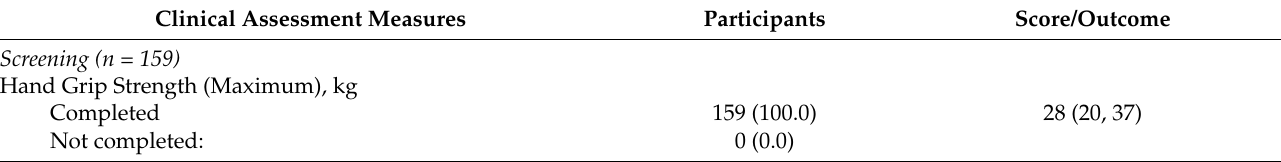
Table 4. Adherence to and scores of the clinical screening and assessment measures within the